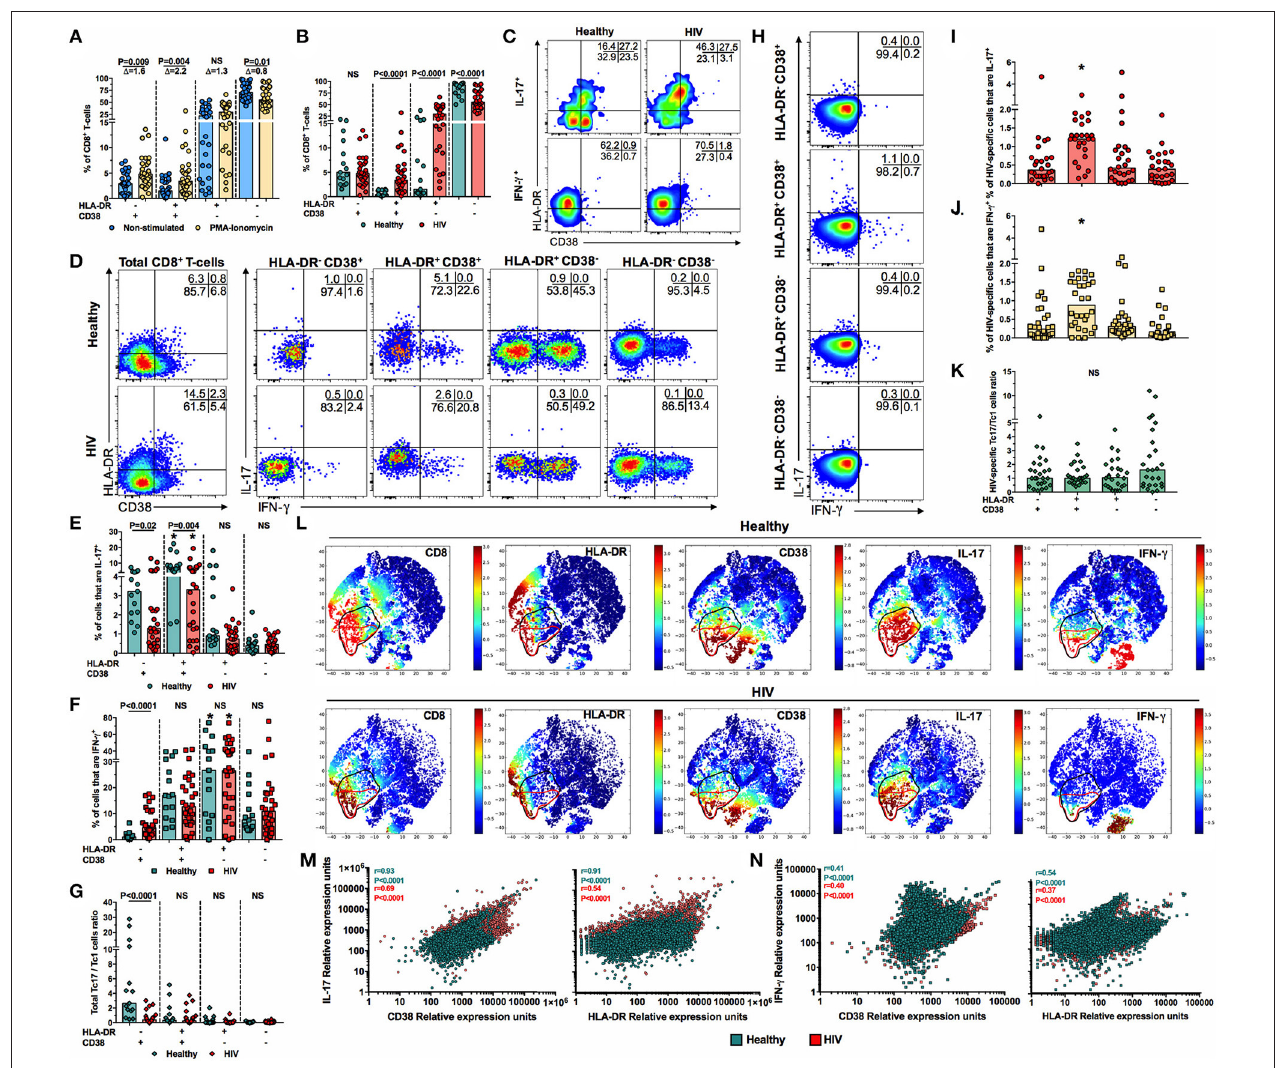
FIGURE 3 | Low frequency of activated Tc17 cells in PLWH. (A) Frequency of HLA-DR- and/or CD38-expressing non-stimulated and PMA-ionomycin-stimulated CD8 + T-cells from PLWH. The 1 of the PMA-ionomycin/non-stimulated cells frequency is shown at the top. The P -value of the Wilcoxon test is shown. (B) Frequency of HLA-DR- and/or CD38-expressing PMA-ionomycin-stimulated CD8 + T-cells from healthy individuals and PLWH. (C) Expression of HLA-DR and CD38 in IL-17 + and IFN- γ + CD8 + T-cells after PMA-ionomycin stimulation in a representative healthy individual and patient living with HIV. (D) Representative pseudocolor plots of the expression of IL-17 and IFN- γ in HLA-DR/CD38-expressing CD8 + T-cells after PMA-ionomycin stimulation in a representative healthy individual and patient living with HIV. (E,F) Frequency of IL-17 + (E) and IFN- γ + (F) cells among HLA-DR- and/or CD38-expressing PMA-ionomycin-stimulated CD8 + T-cells from healthy individuals and PLWH. *Indicate which population, according to the expression of HLA-DR and CD38, had the highest frequency of IL-17 + or IFN- γ + cells, respectively, when healthy individuals or PLWH were analyzed independently ( P ≤ 0.02, Dunn’s post-hoc test). (G) HLA-DR and/or CD38-expressing total Tc17/Tc1 cells ratio in healthy individuals and PLWH. (H) Representative pseudocolor plots of the expression of IL-17 and IFN- γ in HLA-DR/CD38-expressing CD8 + T-cells after Gag peptides stimulation in a representative patient living with HIV. (I,J) Frequency of IL-17 + (I) and IFN- γ + (J) cells among HLA-DR- and/or CD38-expressing Gag-stimulated CD8 + T-cells from PLWH. * P ≤ 0.04 vs. all the groups; Dunn’s post-hoc test. (K) HLA-DR and/or CD38-expressing HIV-specific Tc17/Tc1 cells ratio in PLWH. (L) Cell ACCENSE t-SNE plots of CD8, HLA-DR, CD38, IL-17, and IFN- γ expression in polyclonally-stimulated cells from a representative healthy individual and a subject living with HIV ( M = 30,000). The black and red circles indicate, respectively, IL-17- and IFN- γ -positive CD8 + T-cells. (M,N) Correlation between the IL-17 (M) and IFN- γ (N) relative expression units and that of CD38 and HLA-DR. A total of 30,000 cells were collected from all the healthy individuals and PLWH, and computed. The r and P -value of the Pearson test are shown. In (B,E–G) the P -value of the Mann-Whitney test is shown. NS, Not statistically